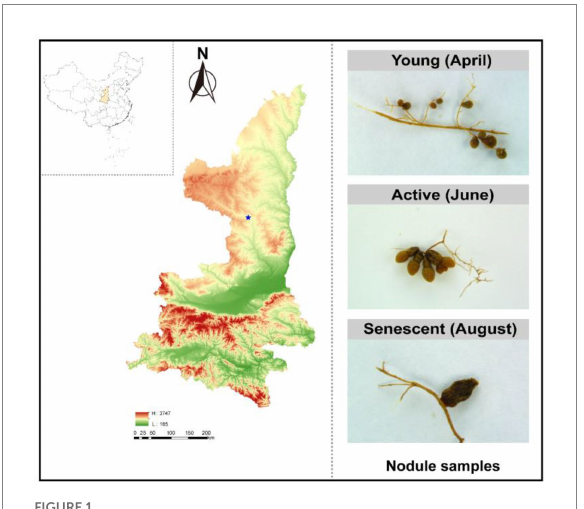
FIGURE 1 Sampling map. Maps showing elevation, and other geographic properties (left). The collected nodules samples from three phases: young phases (April 2021), active phases (June 2021) and senescent phases (August 2021)